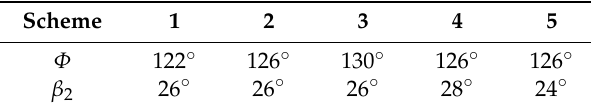
Table 1. Optimized schemes of the blade profile.